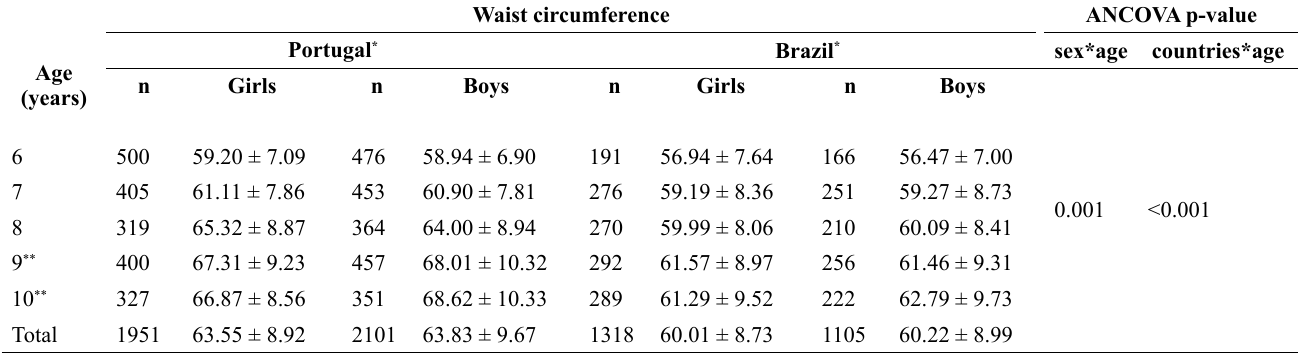
Table 1: Waist circumference in Portuguese and Brazilian children according to age and sex Waist circumference ANCOVA p-value Portugal * Brazil * sex*age countries*age Age Boys Boys (years)